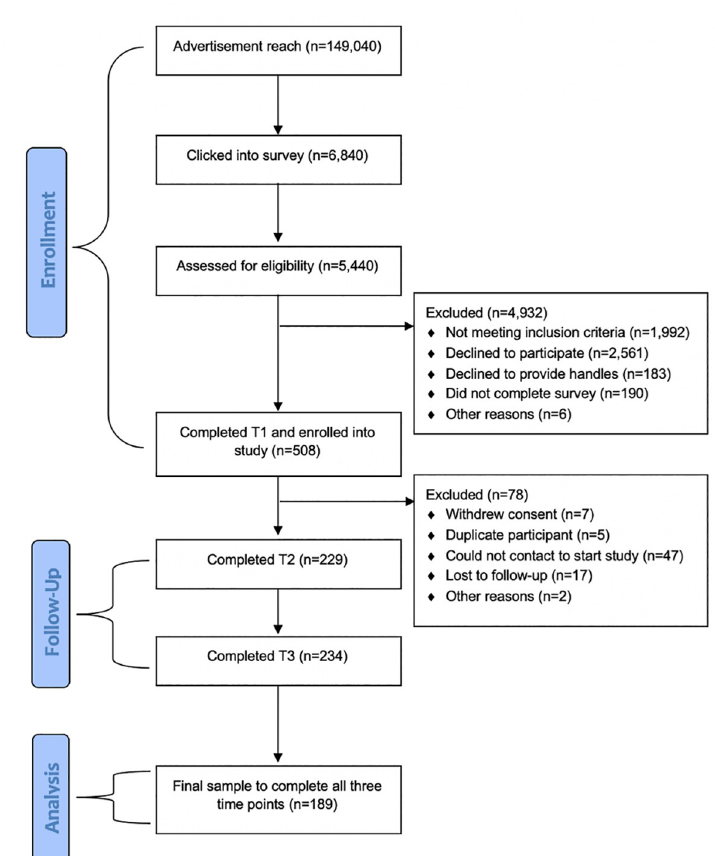
Fig 4. Participant flow diagram from enrolment, follow-up, and data analysis for the #chatsafe intervention.